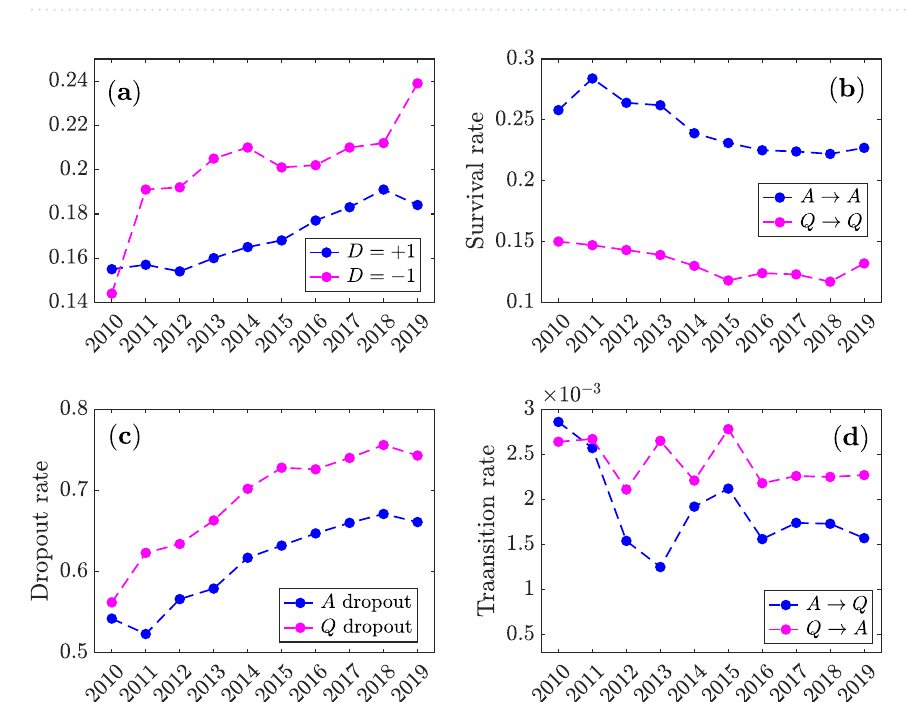
Figure 2. Characterisation of stack overflow’s user base. ( a ) Annual percentage of A - and Q -users ( D = 1 and D = − 1 , respectively, see Eq. (1)). ( b ) Annual survival probabilities for A - (blue) and Q -users (magenta), defined as the empirically estimated probabilities for users belonging to either group to belong to the same group in the following year. ( c ) Annual dropout rates for A - (blue) and Q -users (magenta), defined as the empirically estimated probabilities for users belonging to either group to either leave the platform or fall below the minimum threshold of 10 posts per year to be considered in our analysis. ( d ) Annual transition rates from A - to Q -users (blue) and vice versa (magenta), defined as the empirically estimated probabilities for users belonging to one group to transition to the other one the following